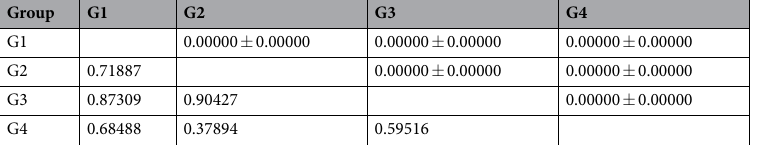
Table 3. The F ST value between the groups based on concatenated sequences. F ST of four groups of C. ciliata (below the diagonal); p value ( ± SE) of four groups of C. ciliata (above the